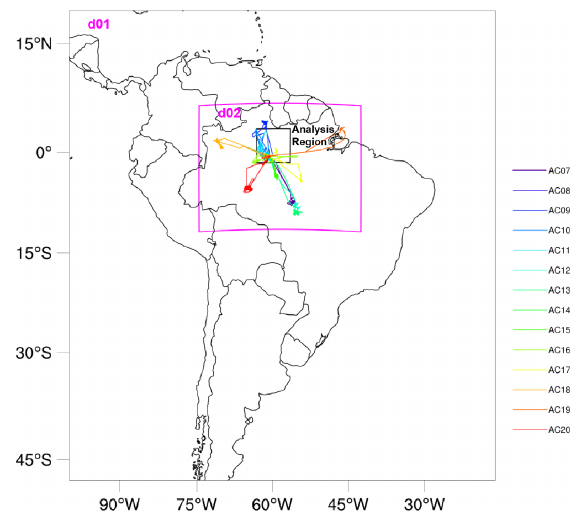
Figure A1. Model domain and tracks of flight AC07 to AC20 from the ACRIDICON-CHUVA campaign. The outer map represents the parent domain with 75km horizontal grid spacing, and the embed- ded square shows the extent of the 15km resolution (d02) domain. The black rectangle is the same as the one marked in Fig. 3a, de- noting the region of the Central Amazon for further analysis in this